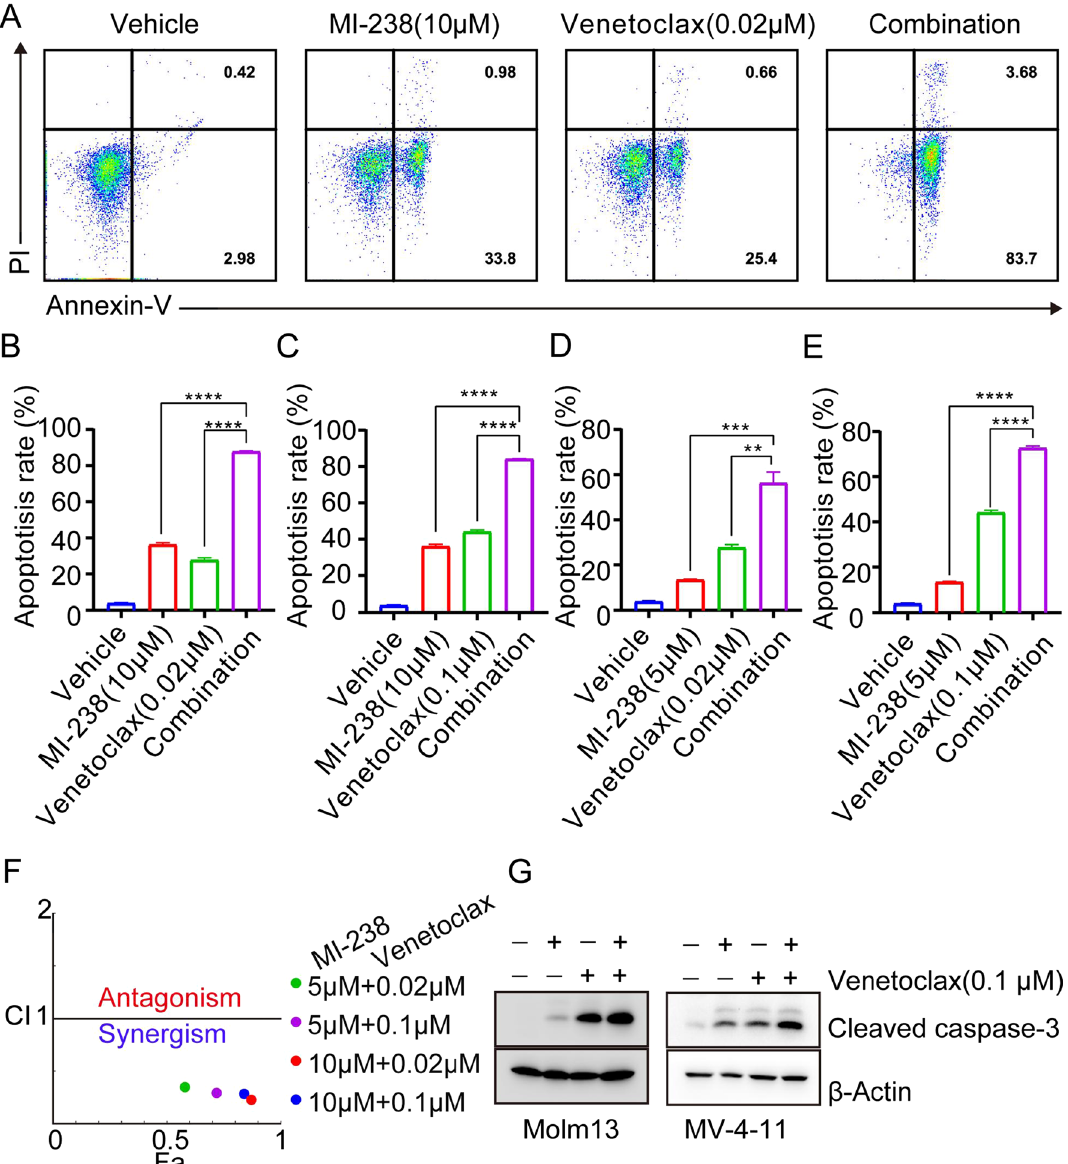
Fig. 5 MI-238 synergizes with venetoclax to induce apoptosis in AML cells. A – E Molm13 cells were treated with indicated concentrations of MI-238, venetoclax, or their combination for 48 h, followed by apoptosis assay by annexin V staining. Data are represented as mean independent replicates, ** P < 0.01, *** P < 0.001, and **** P < 0.0001 by two-tailed t-test. F The combination index (CI) was calculated by CompuSyn software. G Molm13 and MV-4-11 cells were treated as indicated, and the caspase 3 cleavage was analyzed by western